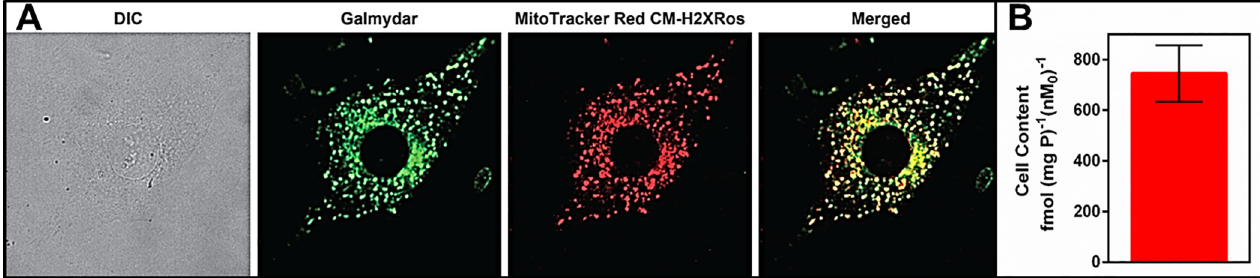
Fig 2. (A) Cellular accumulation of Galmydar and demonstration of its intracellular localization in mitochondria via correlation with Mito-Tracker: Images were acquired using a 60 × objective (all panels represent same magnification) in live H9c2(2–1) cells following 30 min treatment with Galmydar (20 μ M) and MitoTracker Red CM-H2XRos (25 nM). A : DIC; B : Uptake of Galmydar; C : Uptake of MitoTracker Red; D : Merge of B & C . (B) Cellular accumulation of 67 Ga-Galmydar in rat cardiomyoblasts H9c2(2–1) . Shown is a net uptake at 90 minutes (fmol nM 0 − 1 mg protein − 1 ) using the control media. The bar represents the mean of 4 determinations; the line above the bar denotes ±